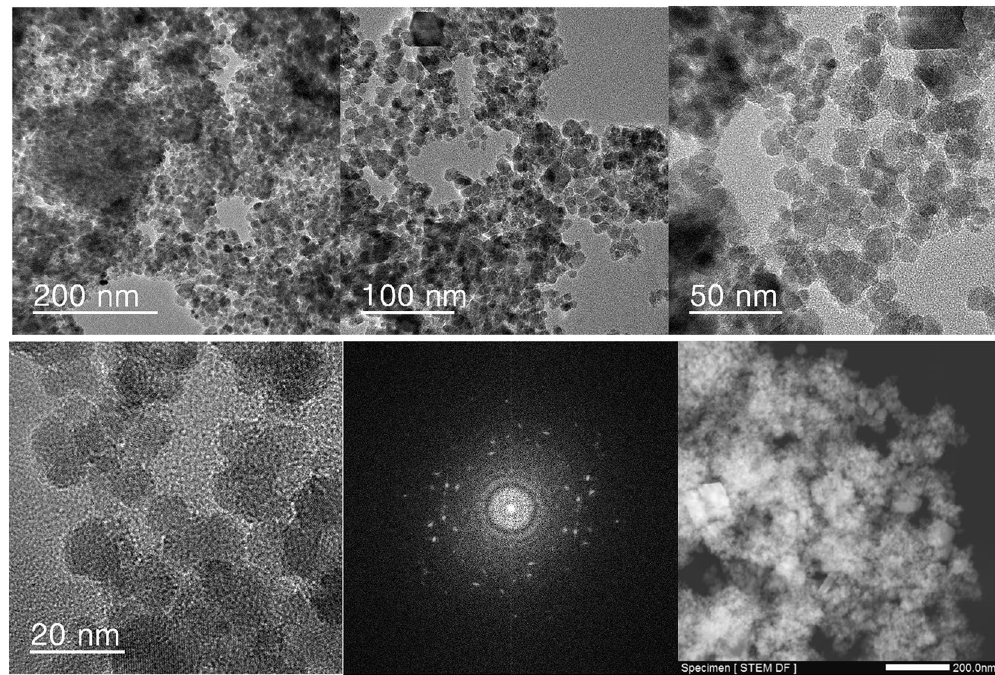
Figure 4. TEM, HRTEM, FFT and STEM images of Ps@Tet@Fe 3 O 4 .